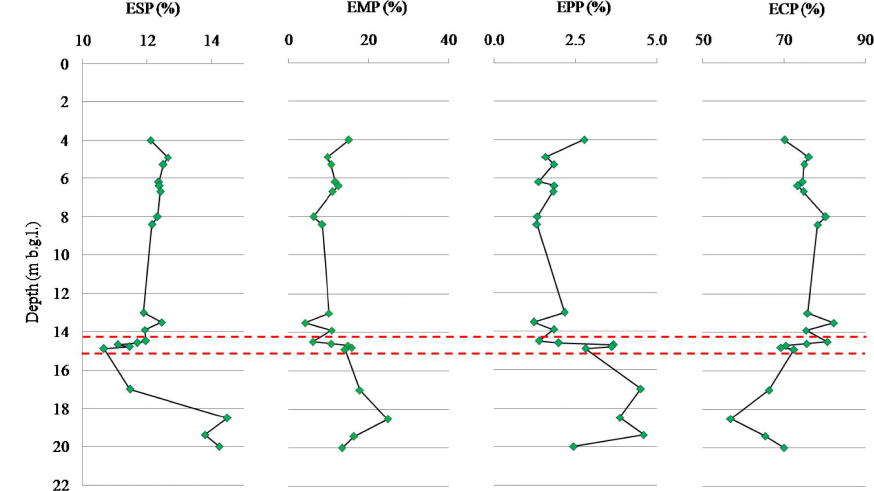
Figure 11. Trends of exchangeable sodium percentage (ESP), exchangeable magnesium percentage (EMP), exchangeable potassium per- centage (EPP) and exchangeable calcium percentage (ECP) variations with depth.